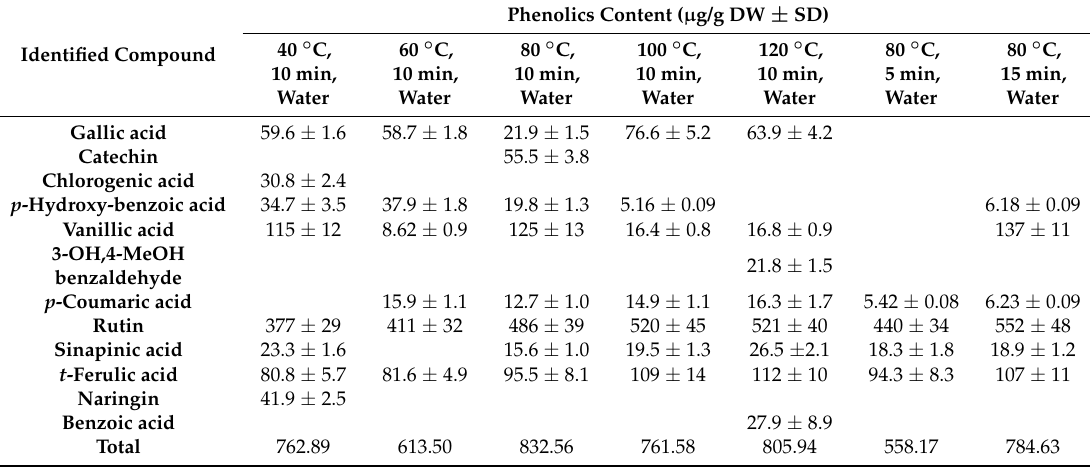
Qualitative and quantitative analysis of the phenolics profile of Atriplex mollis microwave-assisted extracts.